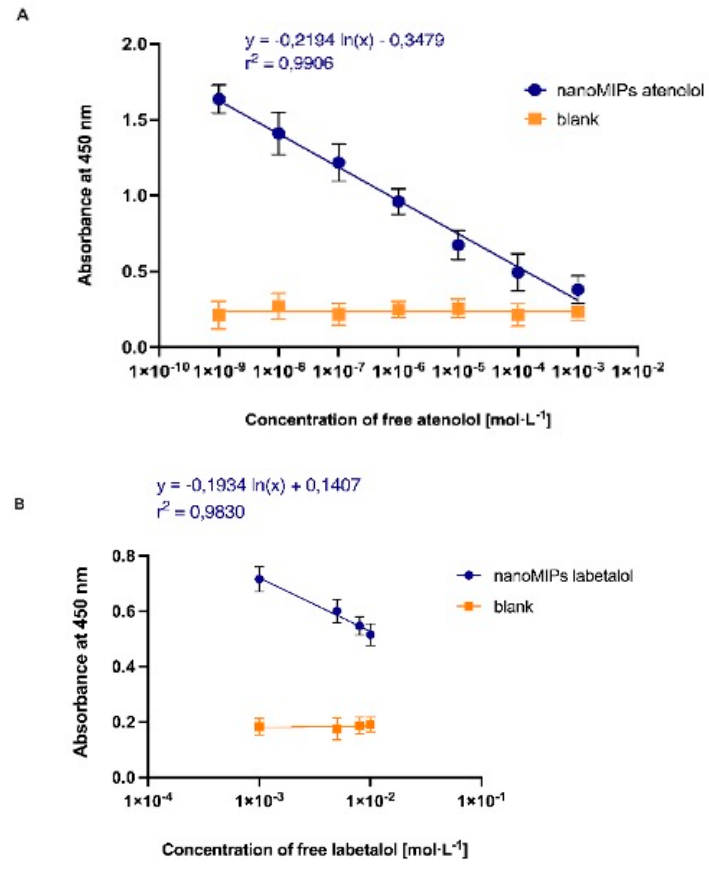
Figure 5. Results of competitive-type pseudo-ELISA assay for nanoMIPs-A ( A ) and nanoMIPs-L ( B ) obtained in water.